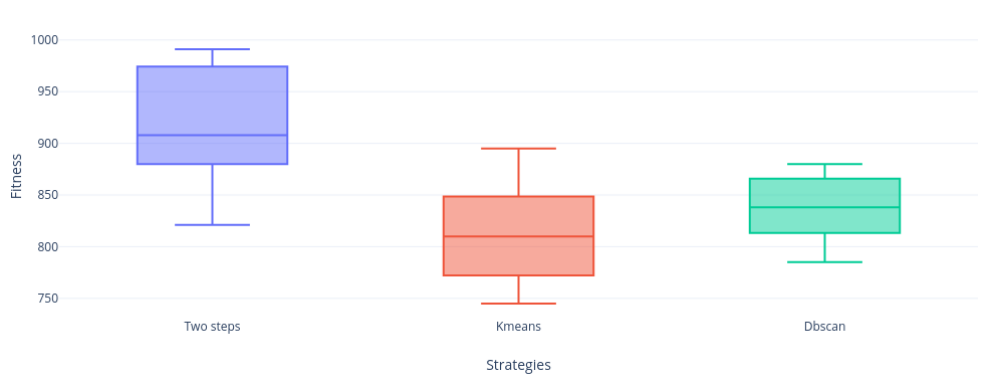
Figure 19. Instance f1 distribution.